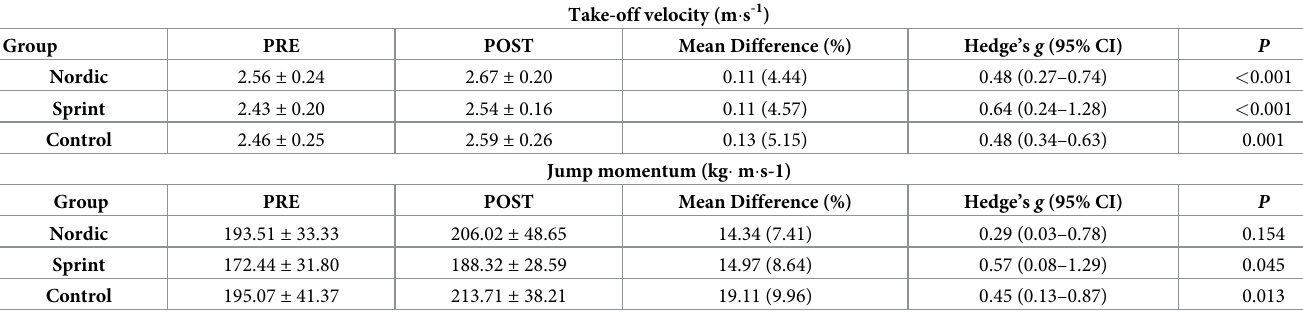
Table 7. Pairwise comparisons of countermovement jump measures for all training groups.